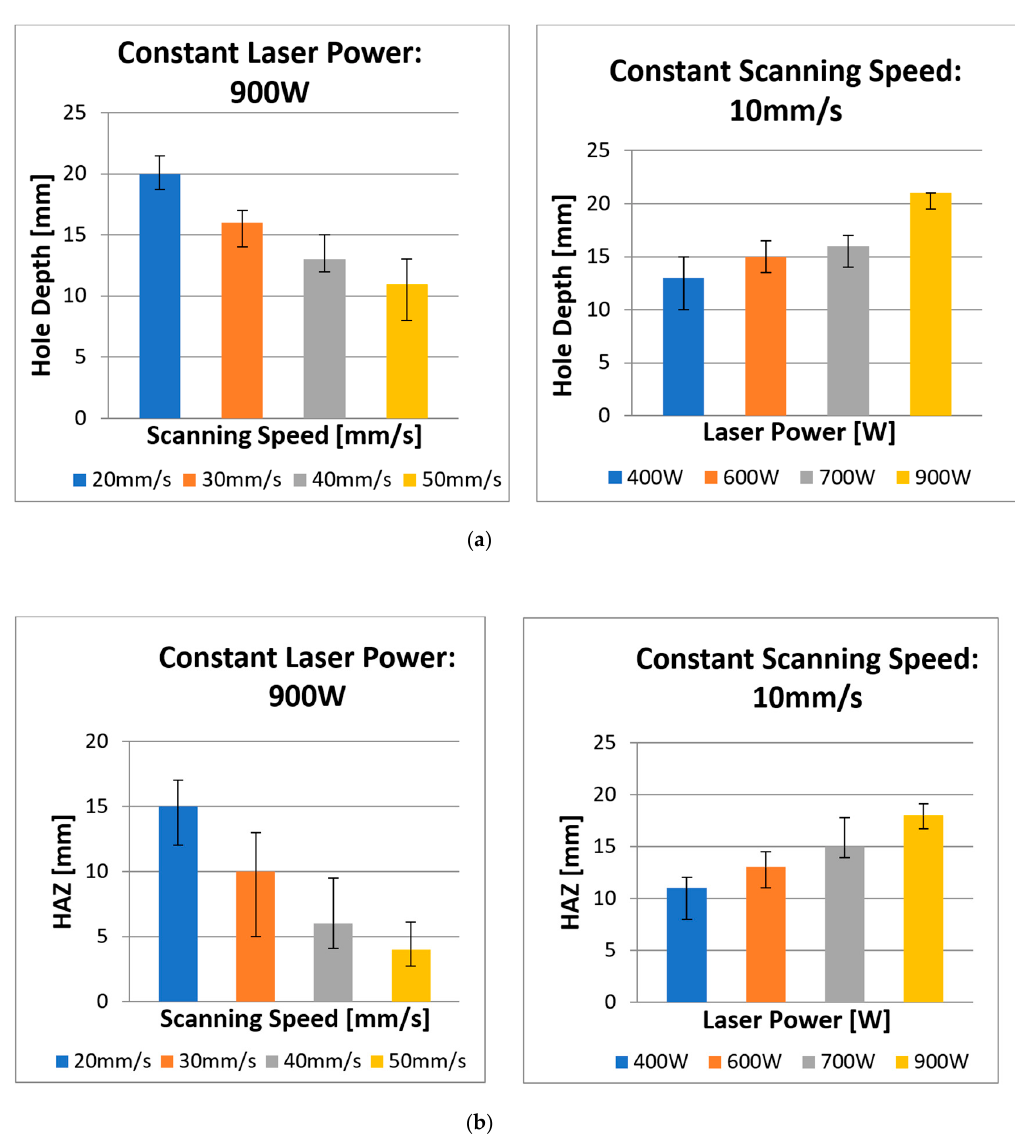
Figure 10. E ff ect of laser power / scanning speed at a constant speed / power on ( a ) hole depth and Figure 10. Effect of laser power/scanning speed at a constant speed/power on ( a ) hole depth and ( b ) HAZ. ( b )